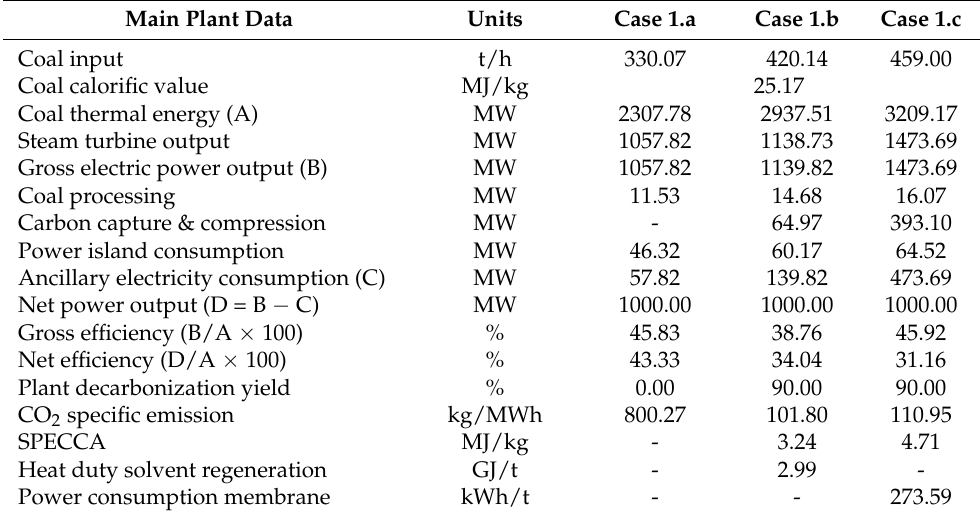
Table 2. Global plant performance indexes of benchmark